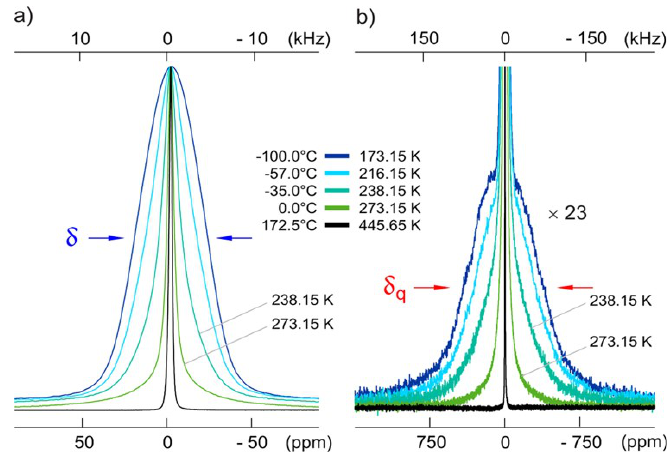
Figure 18. (Left) Single Pulse 7 Li spectra of Li 6.5 La 3 Zr 1.75 Mo 0.25 O 12 (LLZMO) with temperature. (Right) The same temperature dependent spectra zoomed in to see the averaging of quadrupolar e ff ects [63].